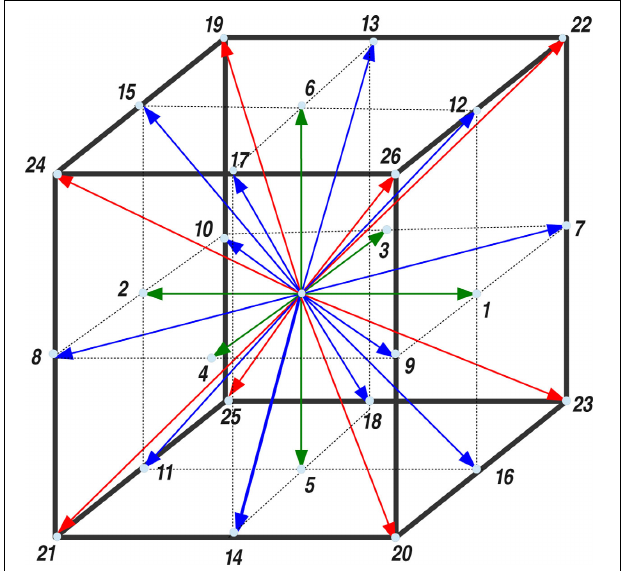
FIGURE 1 | The unit cell of the D3Q27 lattice. The nearest neighbors, next-nearest neighbors and next-next nearest neighbors are shown in green, blue, and red, respectively. The weighting factors, w i , for the D3Q27 are: w 0 = 8 / 27 (the cell-center), w i = 2 / 27 ( i = 1 − 6), w i = 1 / 54 ( i = 7 − 18), and w i = 1 / 216 ( i = 19 −